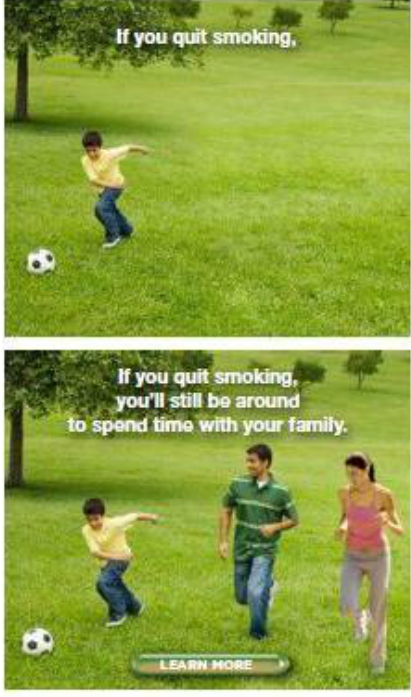
Figure 1. Gain-framed/deep-targeted ad for